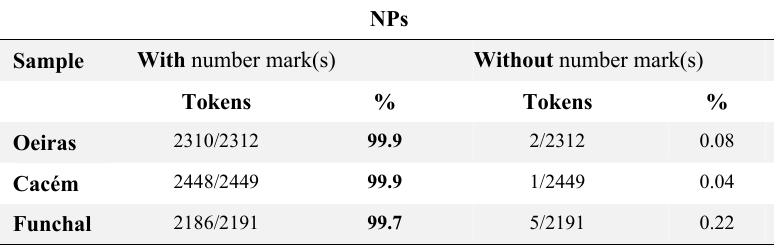
Table II. Distribution of NPs with and without number mark within urban varieties of EP NPs Sample With number